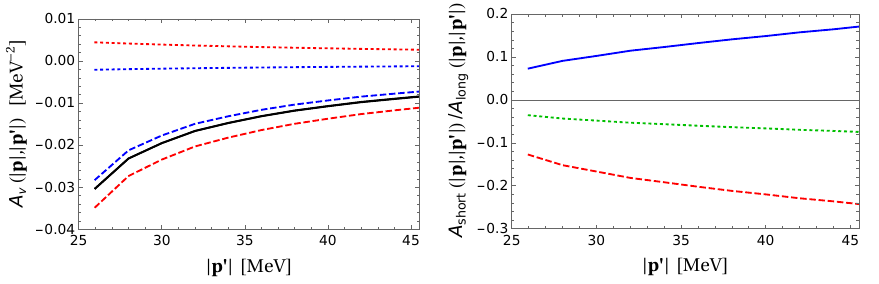
Figure 3. nn → ppe − e − amplitude A ν as a function of the final-state NN relative momentum | p (cid:2) | , for initial-state relative momentum | p | = 25MeV. Left: long-distance (dashed), short-distance (dotted), and total (solid) contribution for two di ff erent regulators. Right: ratio of short-to-long distance amplitudes for di ff erent regulators. Figures taken from Ref.